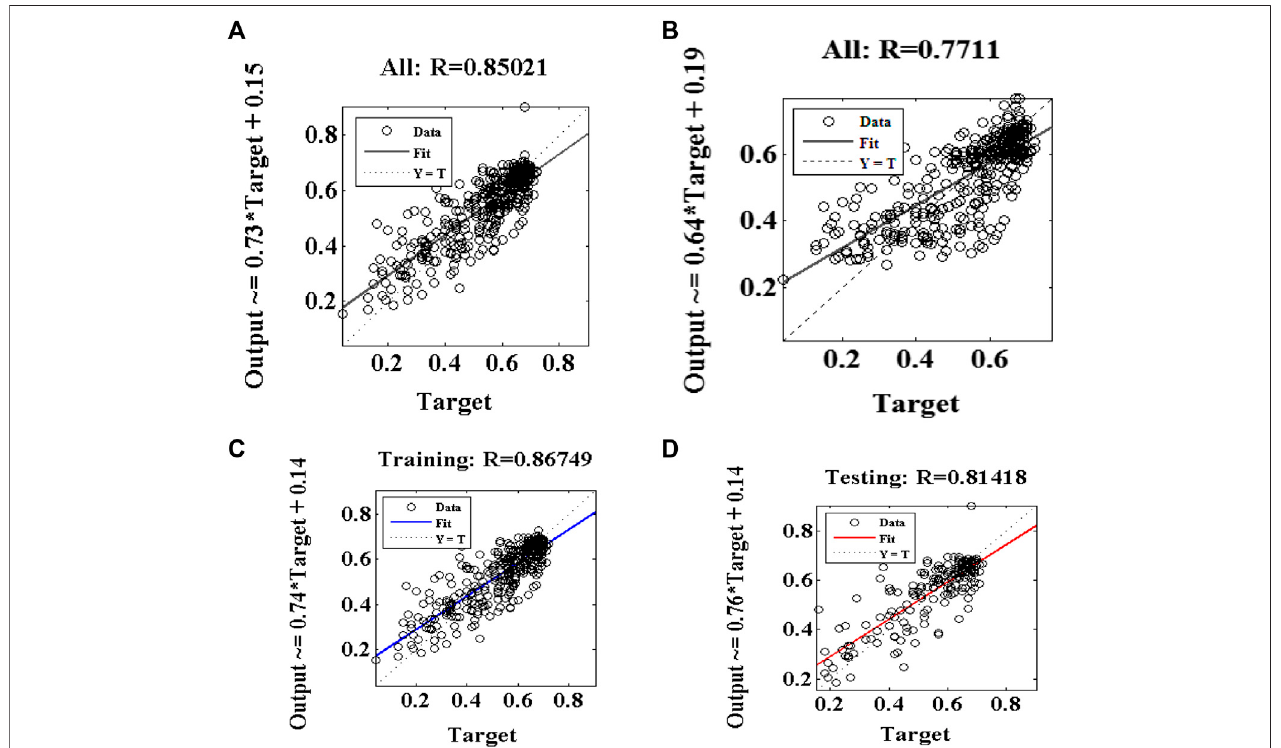
FIGURE 6 | (A,B) Regression plot of. ANFIS . (C,D) Training and testing plots through ANFIS network.